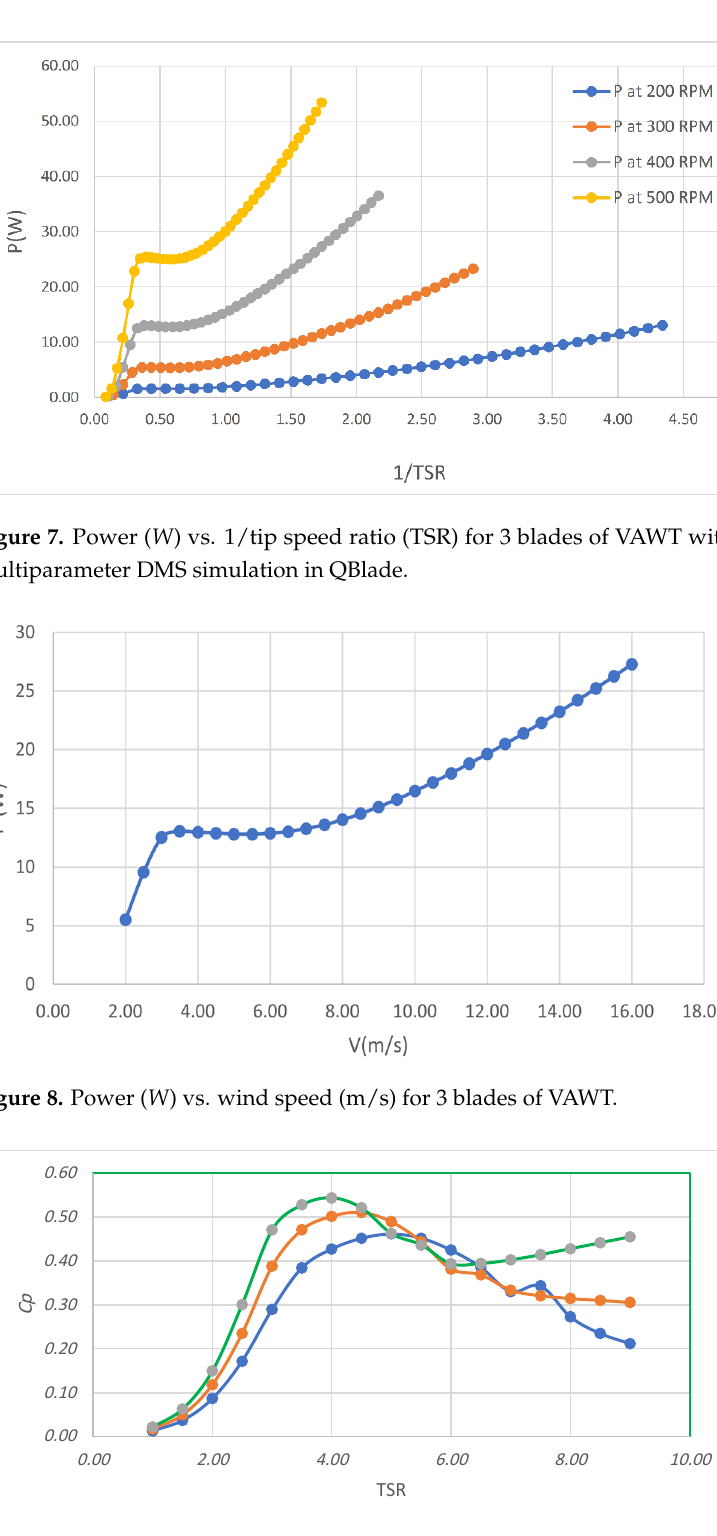
Figure 6. Torque vs. tip speed ratio (TSR) for 3 blades of VAWT.